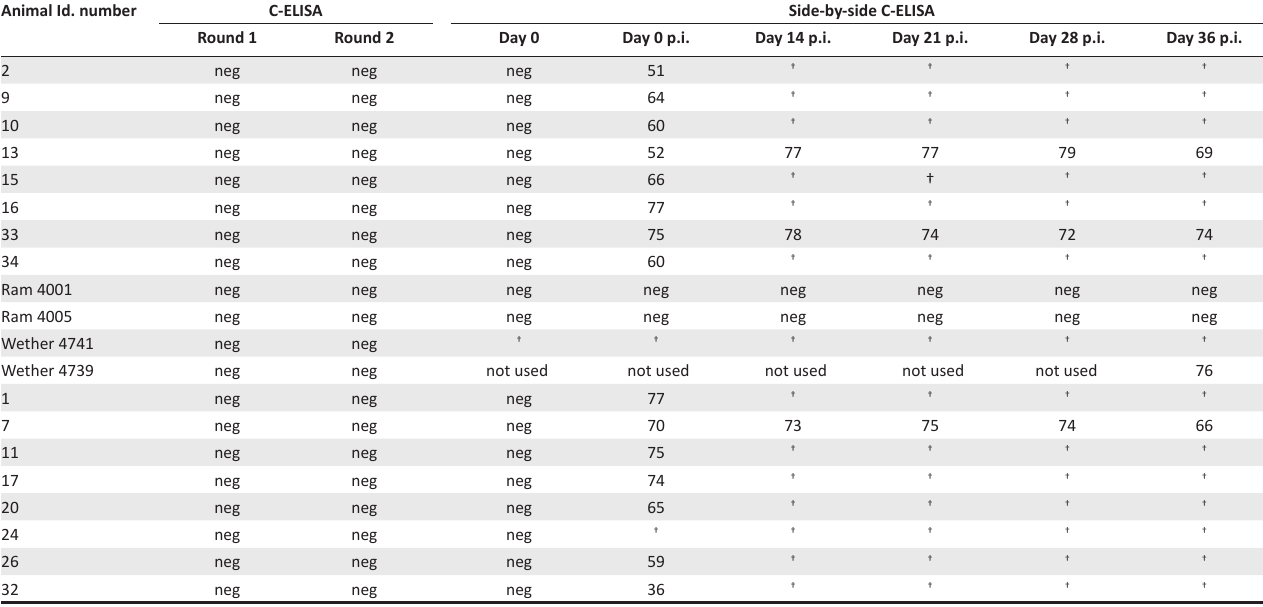
TABLE 4: C-ELISA serology results for donors inoculated with BTV and flushed after 7 days (Experiment 2). Animal Id.